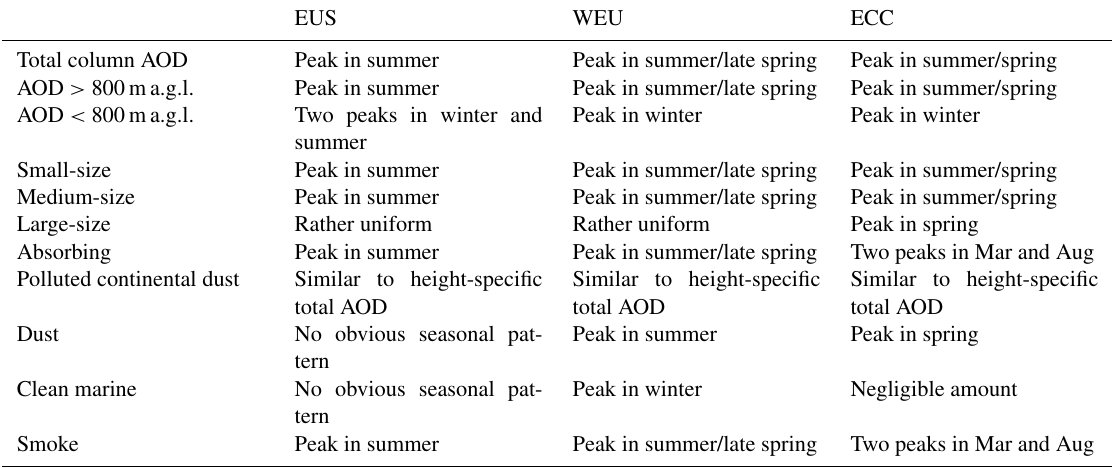
Table 1. Summary of the seasonal variations of the total, height-specific, and type-specific AOD. EUS WEU ECC Total column AOD Peak in summer Peak in summer/late spring Peak in summer/spring AOD > 800ma.g.l. Peak in summer Peak in summer/late spring Peak in summer/spring AOD < 800ma.g.l. Two peaks in winter and Peak in winter Peak in winter summer Small-size Peak in summer Peak in summer/late spring Peak in summer/spring Medium-size Peak in summer Peak in summer/late spring Peak in summer/spring Large-size Rather uniform Rather uniform Peak in spring Absorbing Peak in summer Peak in summer/late spring Two peaks in Mar and Aug Polluted continental dust Similar to height-specific Similar to height-specific Similar to height-specific total AOD total AOD total AOD Dust No obvious seasonal pat- Peak in summer Peak in spring tern Clean marine No obvious seasonal pat- Peak in winter Negligible amount tern Smoke Peak in summer Peak in summer/late spring Two peaks in Mar and